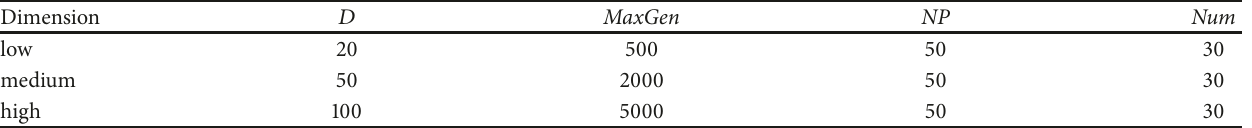
Table 2: The related parameter values for testing the three algorithms.